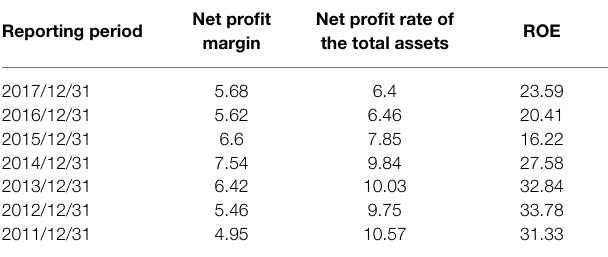
TABLE 6 | Haier profitability index.